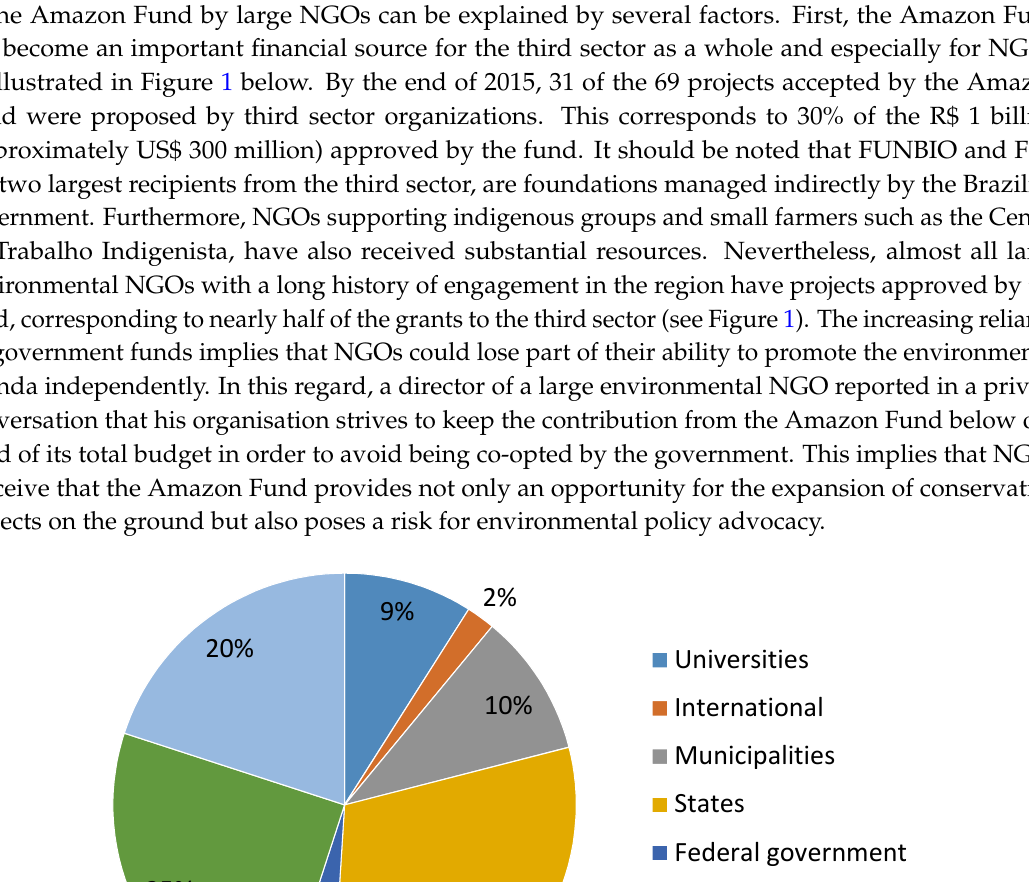
Figure 1. Projects funded by the Amazon Fund categorised according to the nature of the party responsible between 2008 and 2015. Data from BNDES (Brazilian Development Bank).